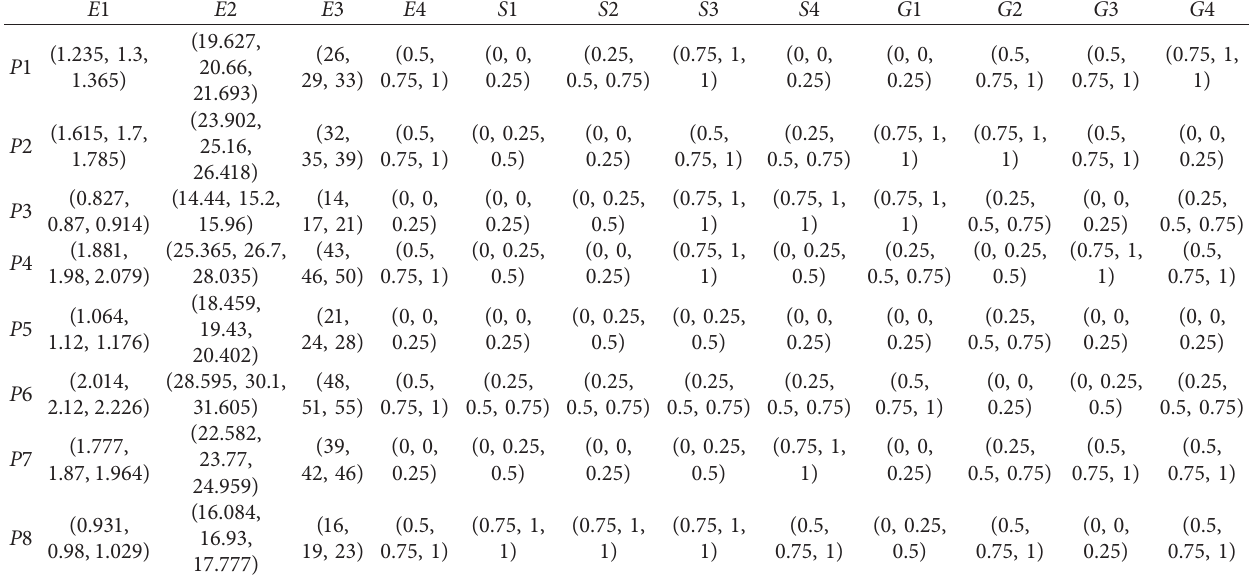
Table 42: Decision matrix in fuzzy